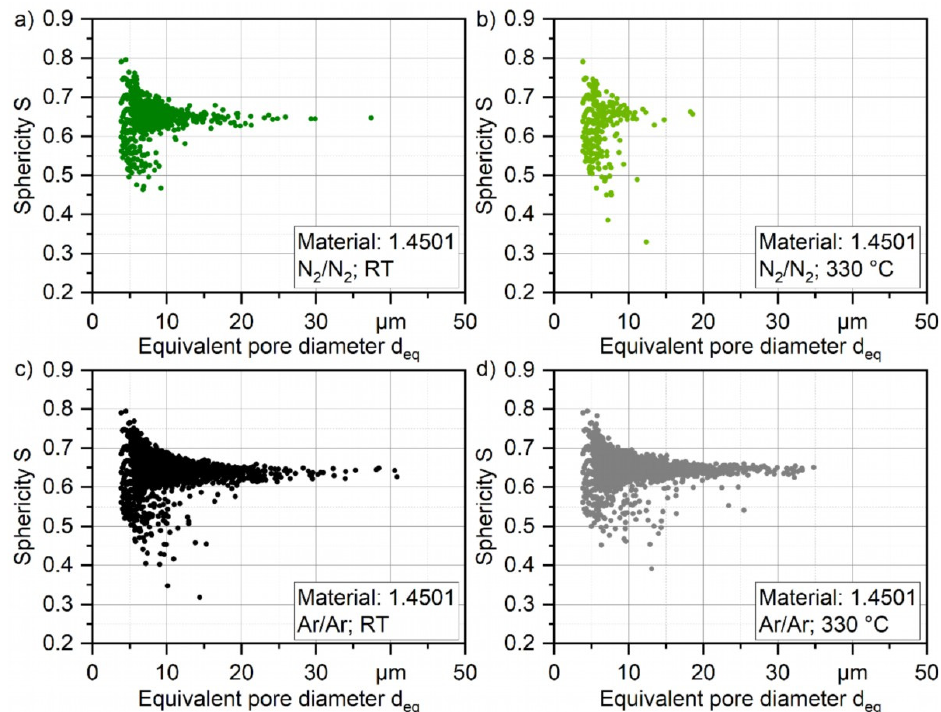
Figure 11. Shape of porosity of gas-atomized X2CrNiMoCuWN25-7-4 powders (particle size 20–63 µm, voxel size 1.56 µm) ( a ) under N 2 /N 2 at RT; ( b ) under N 2 /N 2 at 330 °C; ( c ) Ar/Ar at RT; and ( d ) under Ar/Ar at 330 °C. Table 8. Porosity of the different powder batches based on XRM.